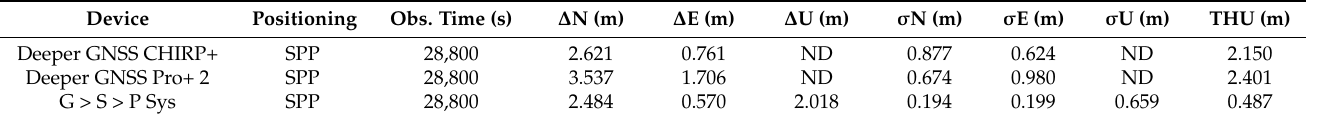
Table 9. Performance in real-time static SPP of Deeper Smart Sonar CHIRP+, Deeper Smart Sonar Pro+ 2 and G > S > P Sys.